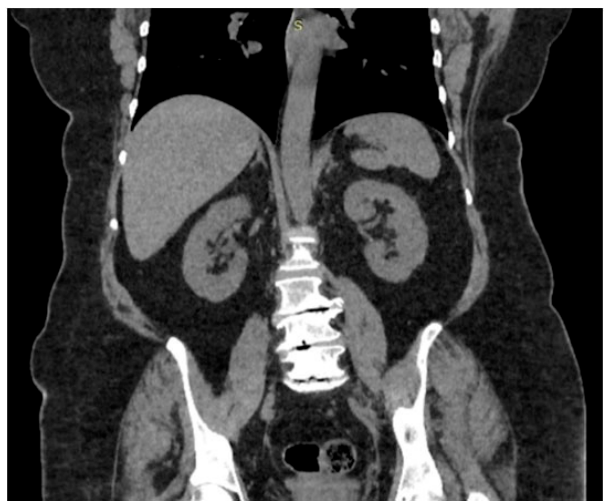
Figure 7. CT scan. No stones in the left upper urinary tract (UUT).